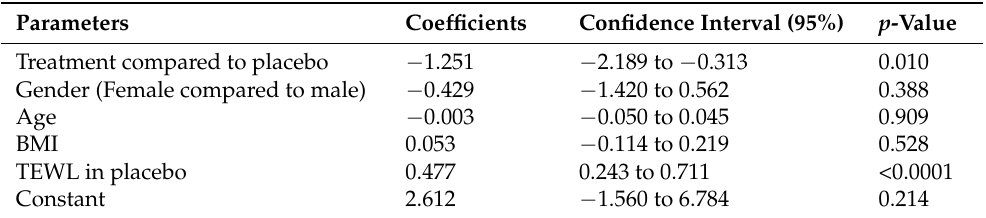
Table 6. Linear regression analysis of changes in the transepidermal water loss (TEWL) after 4 weeks of treatment.